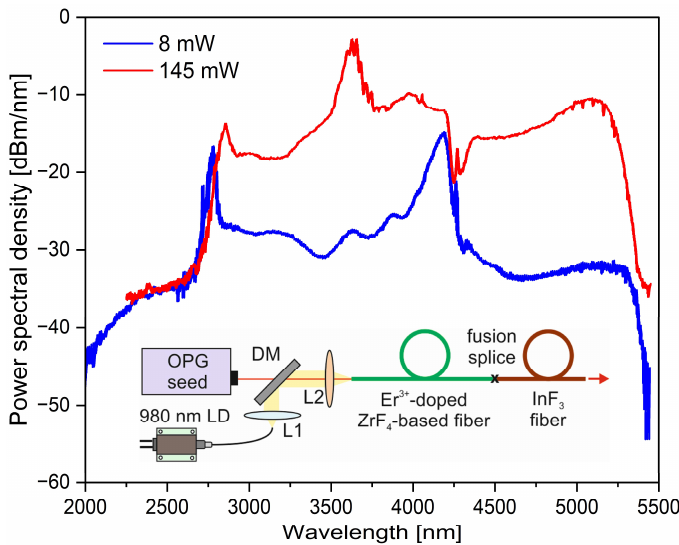
Figure 7. SC spectra measured for the average output power of 8 mW (fiber core diameter of 11–12 μm) and 145 mW (fiber core diameter of 12.5–14.5 μm). Inset, in-amplifier setup for SC generation in the InF 3 fiber. SC spectra adopted with permission from [104]. Copyright 2018, Springer Nature.